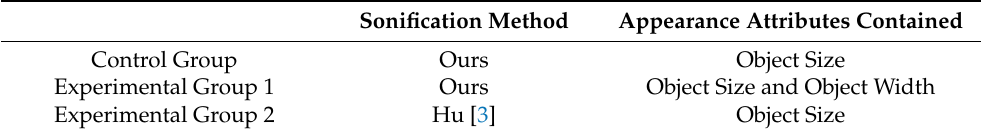
Table 5. The experimental settings of the control group and the experimental group included the sonification method and appearance attributes of each